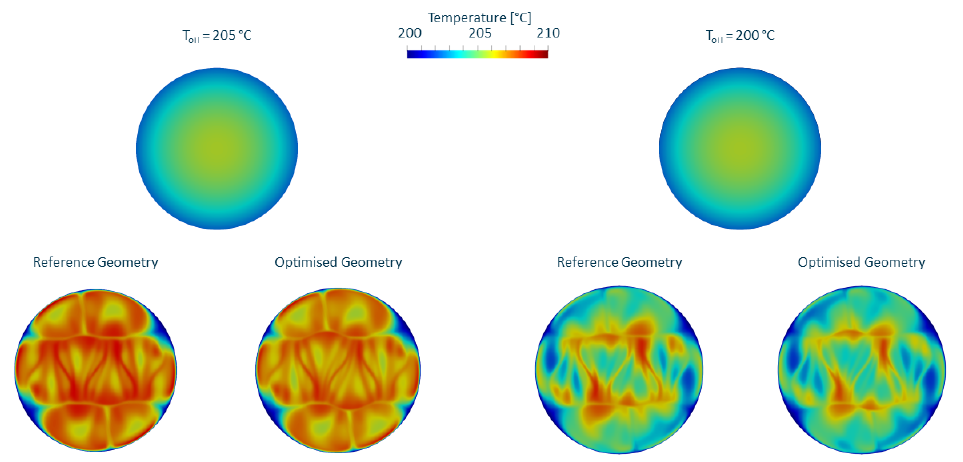
Figure 9. Thermal mixing for reference geometry and geometry optimised for pressure loss for an oil temperature 5 ◦ C above melt temperature ( left ) and at melt temperature ( right ).